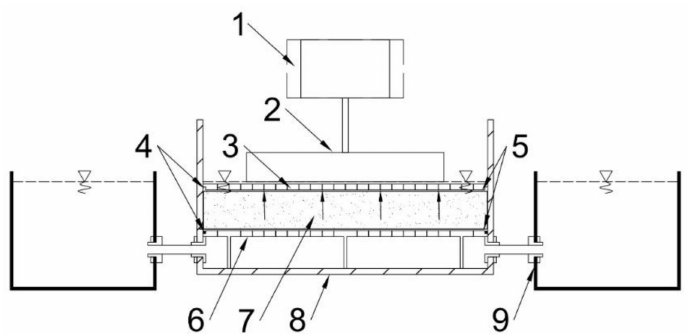
Figure 1. Test apparatus (Mecmesin multitest-2.5xt) with the experimental setup. ( 1 ) ILC pressure sensor, ( 2 ) pressure plate, ( 3 ) porous upper plate, ( 4 ) rubber o-ring, ( 5 ) filter paper, ( 6 ) porous base plate, ( 7 ) superabsorbent polymer (SAP)-soil mixture, ( 8 ) experimental cylinder, ( 9 ) deionized (DI) water